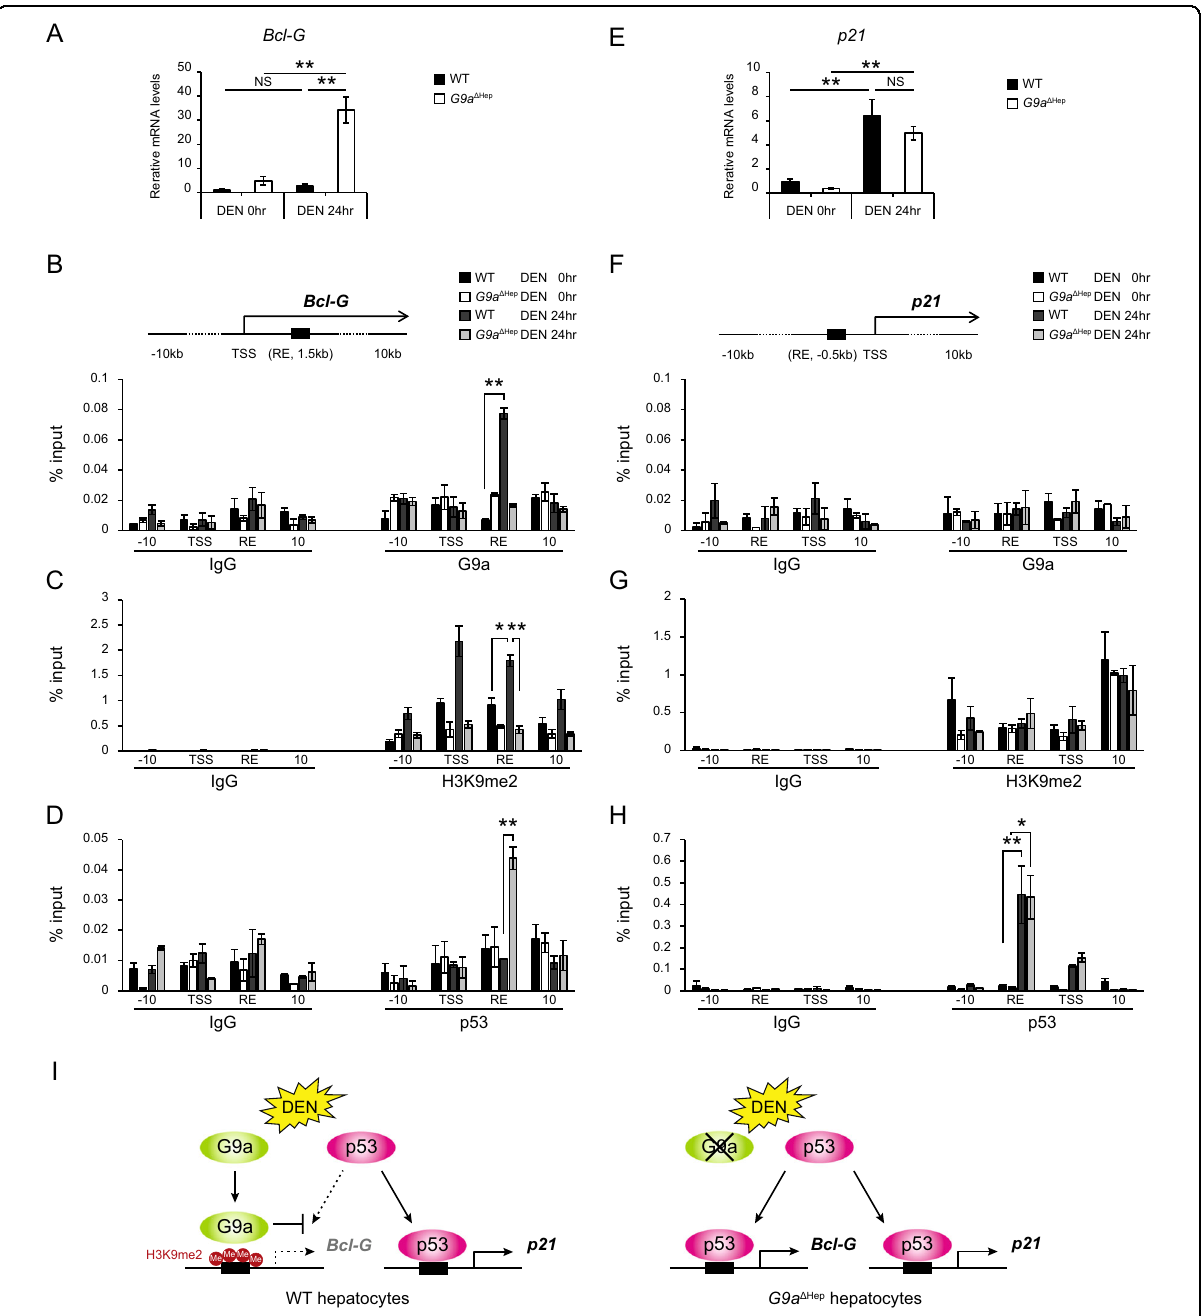
Fig. 5 G9a inhibits p53 recruitment to its response element on Bcl-G in an H3K9 methylase-dependent manner. A , E Relative expression levels of Bcl-G and p21 are determined by qRT-PCR in WT and G9a Δ Hep mice livers before and after a high dose of diethylnitrosamine (DEN) administration (each, n = 3; ** p < 0.01, NS not signi fi cant, Student ’ s t test). B – D , F – H Chromatin immunoprecipitation analyzes G9a, p53, and H3K9me2 binding at the indicated loci of Bcl-G and p21 . The recruitment of G9a and increased H3K9me2 levels are shown in the Bcl-G gene ( B , C ), but not in the P21 gene ( F , G ) after a high dose of DEN. G9a ablation, combined with DEN treatment, allows p53 recruitment onto the Bcl-G locus via a reduction in H3K9me2 levels ( D ). In contrast, p53 is recruited onto the p21 locus after DEN treatment, independent of G9a status ( H ). Transcriptional start site (TSS), p53 response element (RE), and amplicons (10 kb upstream or downstream regions of TSS) are shown in the above diagrams. Results are expressed as the mean ± SEM of three independent experiments. * p < 0.05, ** p < 0.01, Student ’ s t test. I Diagram showing the regulation of p53 target gene expression by G9a. G9a inhibits p53 binding to RE of Bcl-G gene in an H3K9me2-dependent manner and suppresses Bcl-G expression. G9a deletion enables p53 recruitment to Bcl-G gene RE and upregulates Bcl-G